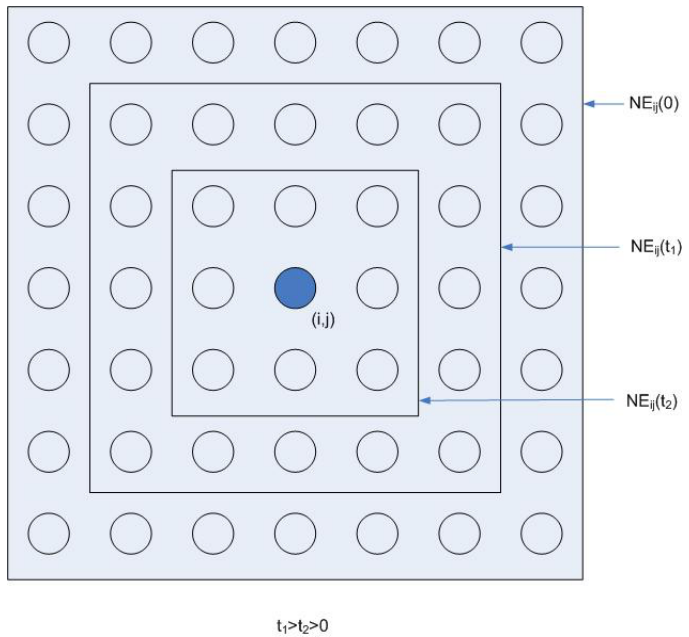
Figure 5. Topological neighborhoods with the progress of training as feature maps are